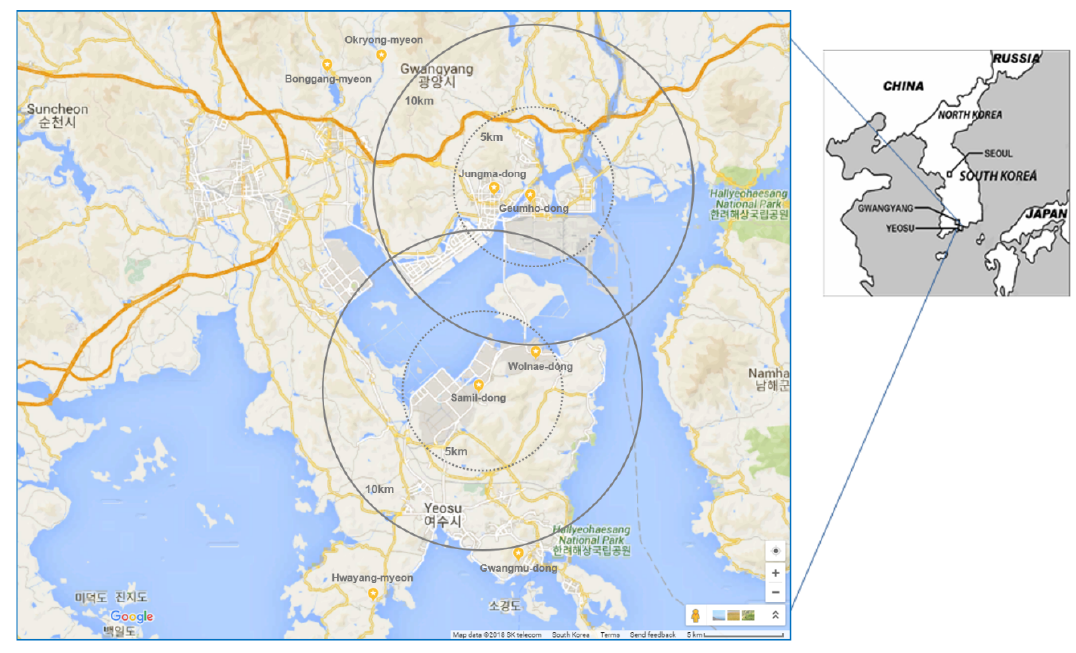
Figure 2. The map of study sites in Gwangyang and Yeosu industrial complexes in Korea.